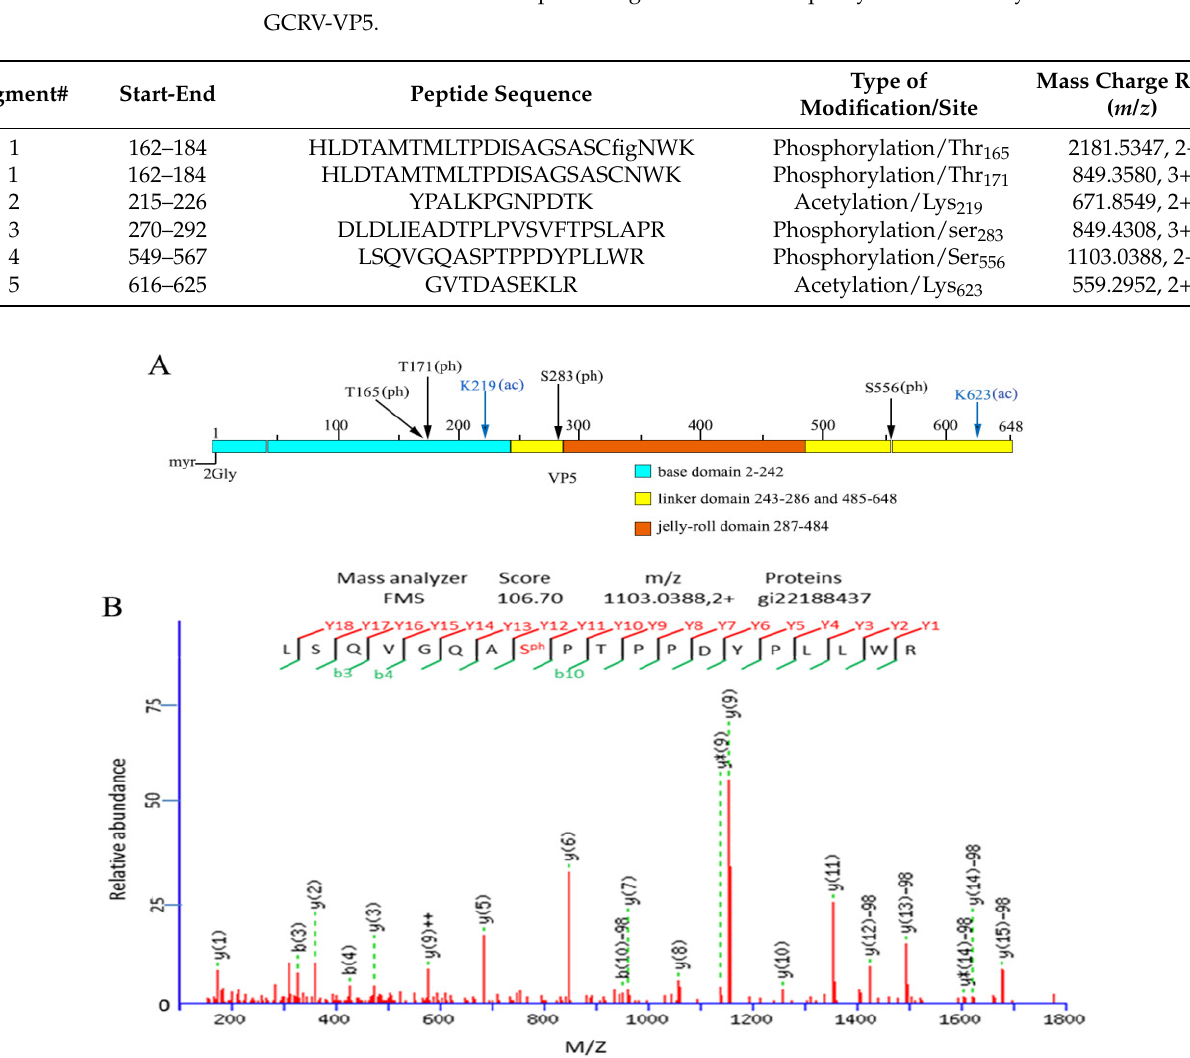
Table 1. Identification of Peptide Fragments with Phosphorylated and Acetylated Modifications in GCRV-VP5.